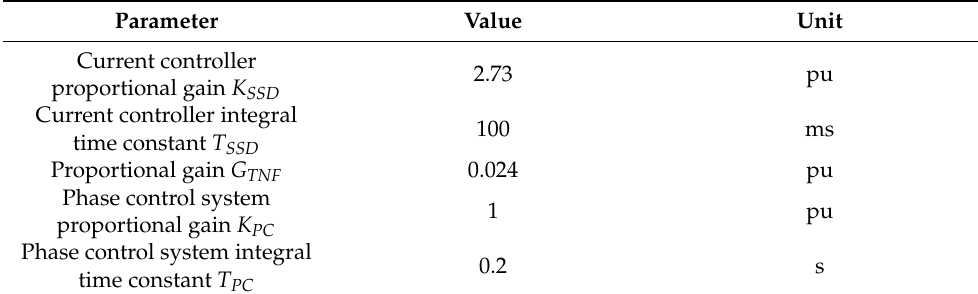
Table 6. Phase control system parameters.